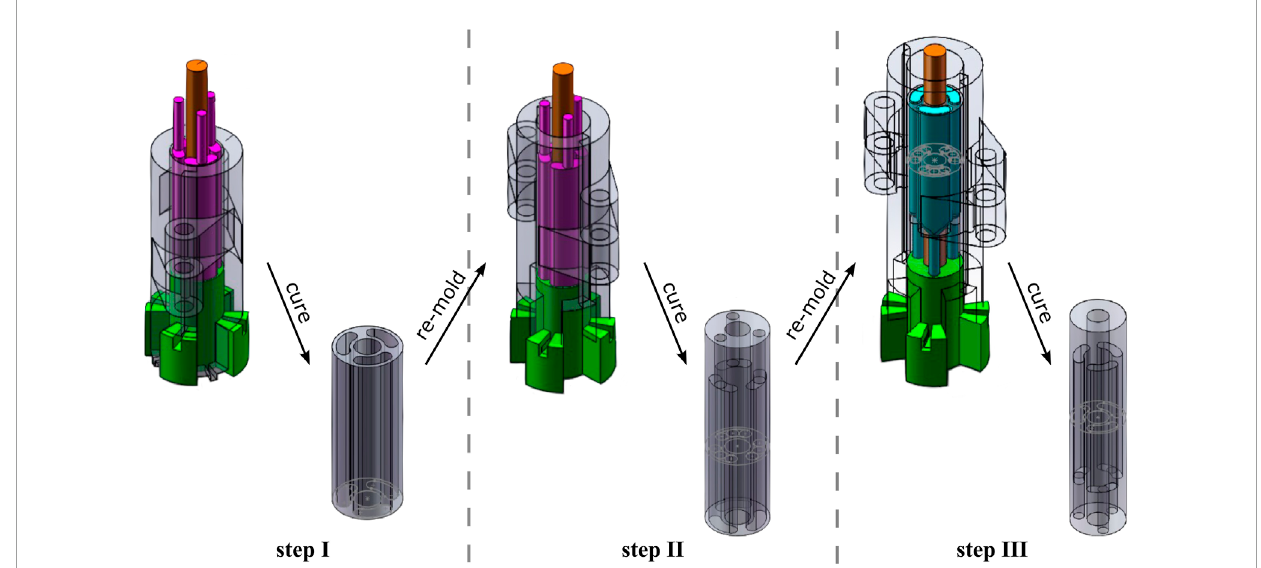
FIGURE 2 The module casting process is divided into three steps: the section with air chambers is molded in step I, while the foot and cap section is fabricated in step II and III respectively. For all steps, the silicone resin is poured from the top side of the mold.